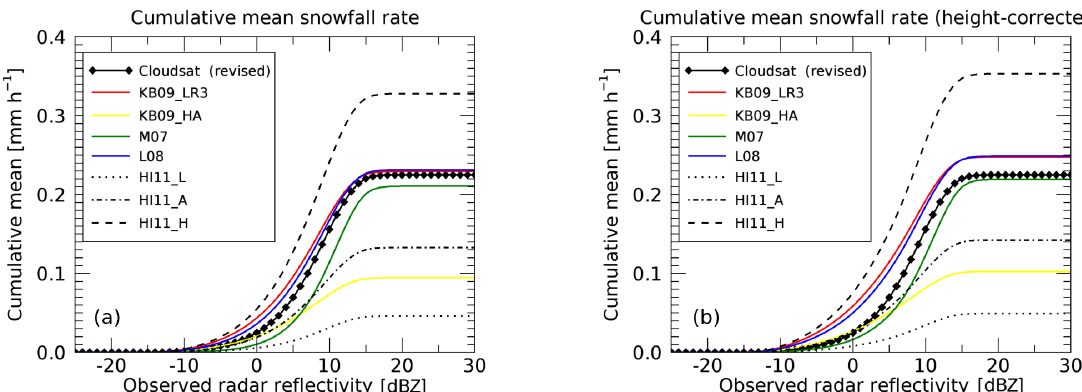
Figure 10. Cumulative snowfall rates derived from all CloudSat observations over Greenland. The thick black line corresponds to the CloudSat-derived surface snowfall rate from SNOWPROF with ground clutter removed (revised, same as in Fig. 6). The other lines corre- spond to the Z – S relations applied to CloudSat reflectivities without height correction (a) and with height correction (b)